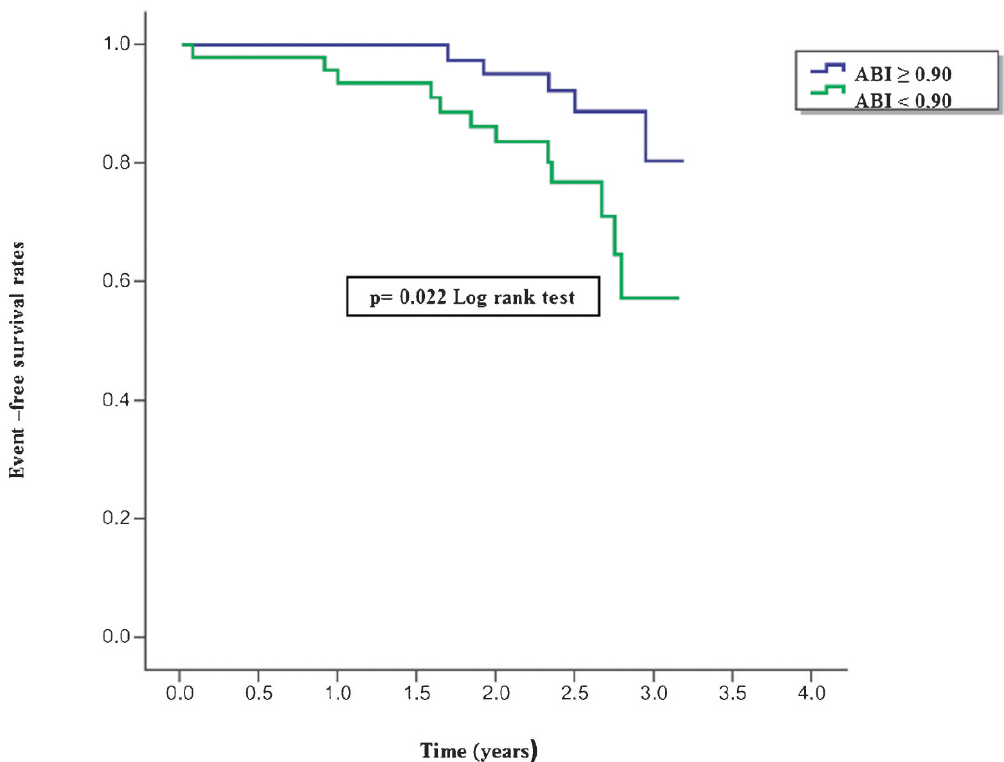
Figure 1 - Event-free survival by ABI categories. Kaplan-Meier estimates showing MACE during the